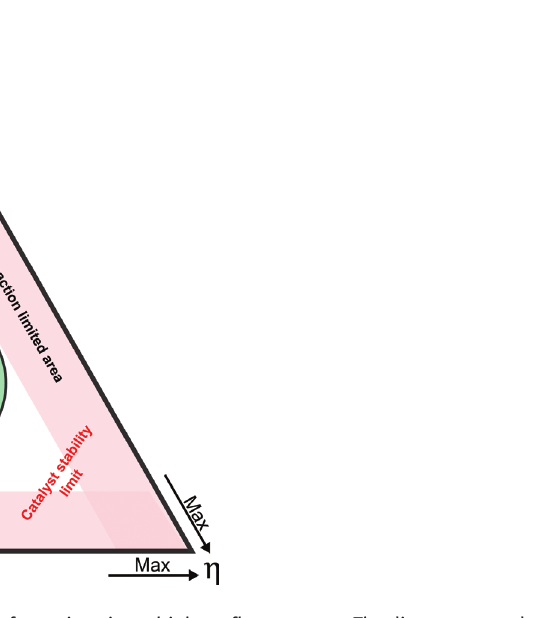
Figure 5 Windows of operation analysis for biotransformations in multiphase flow reactors. The diagram was adapted from Karande et al.